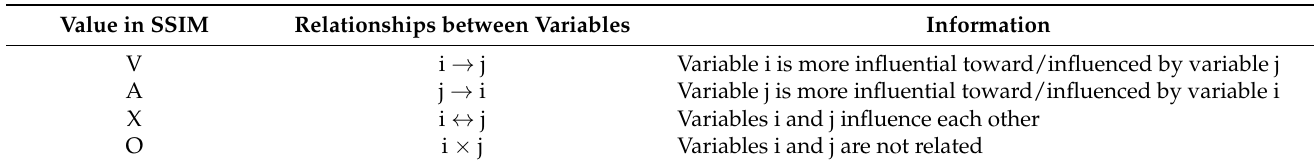
Table 1. Ratings for the VAXO matrix.